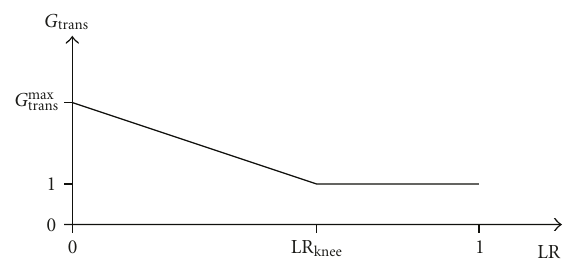
Figure 17: Mapping the likelihood ratio LR to a frame amplifica- tion G trans